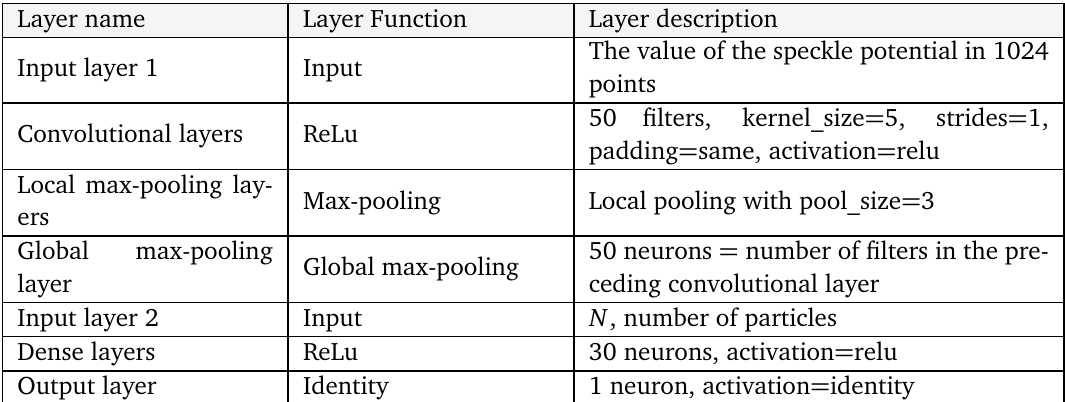
Table 1: Details of the layers constituting the convolutional and the dense parts of our neural network. Definitions are standard, see for instance Ref. [ 39 ]